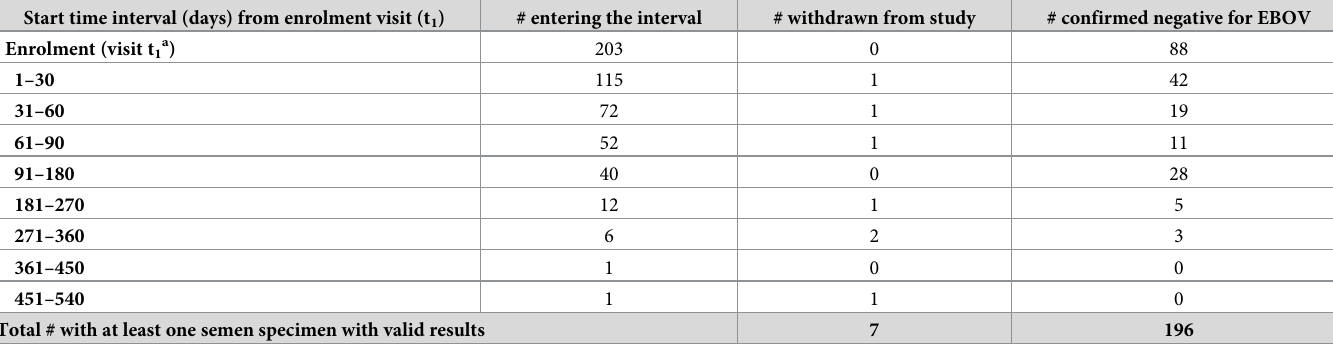
Table 3. Crude follow-up time (in days) and observed confirmed EBOV status of male survivors counting from enrolment visit t 1a . Start time interval (days) from enrolment visit (t 1